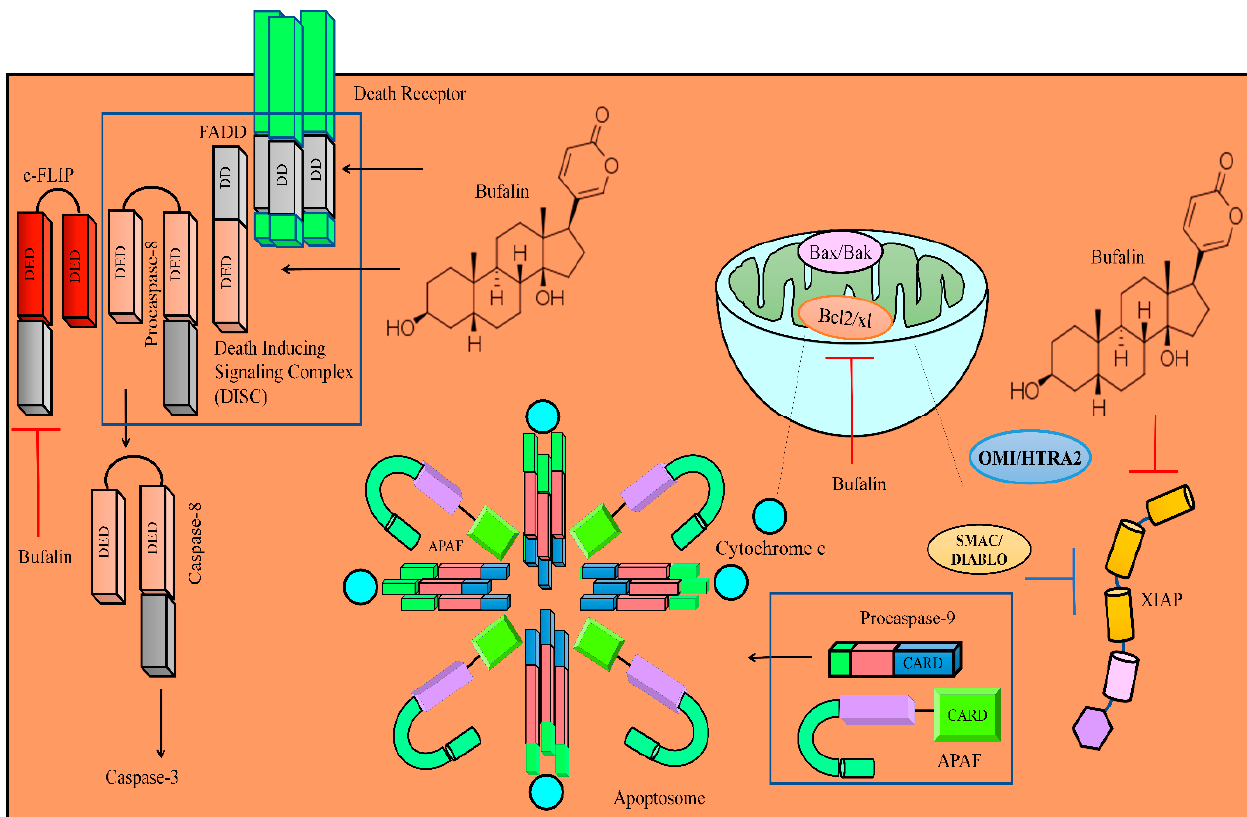
Figure 3. Diagrammatic representation of regulation of TRAIL-mediated apoptotic death by bufalin. Importantly, bufalin enhanced the levels of FADD and DR4/DR5. Bufalin activated death inducible signaling complex. Bufalin triggered the release of cytochrome c and SMAC/DIABLO. C-FLIP prevented the formation of DISC but bufalin prominently reduced the levels of c-FLIP. Bufalin also inhibited Bcl-2 and XIAP.